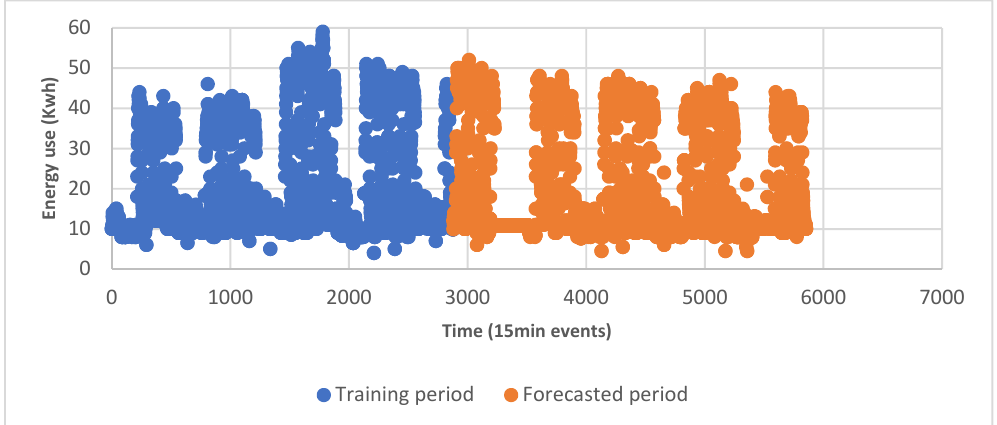
Figure A1. Building energy use over the spring training and testing period.